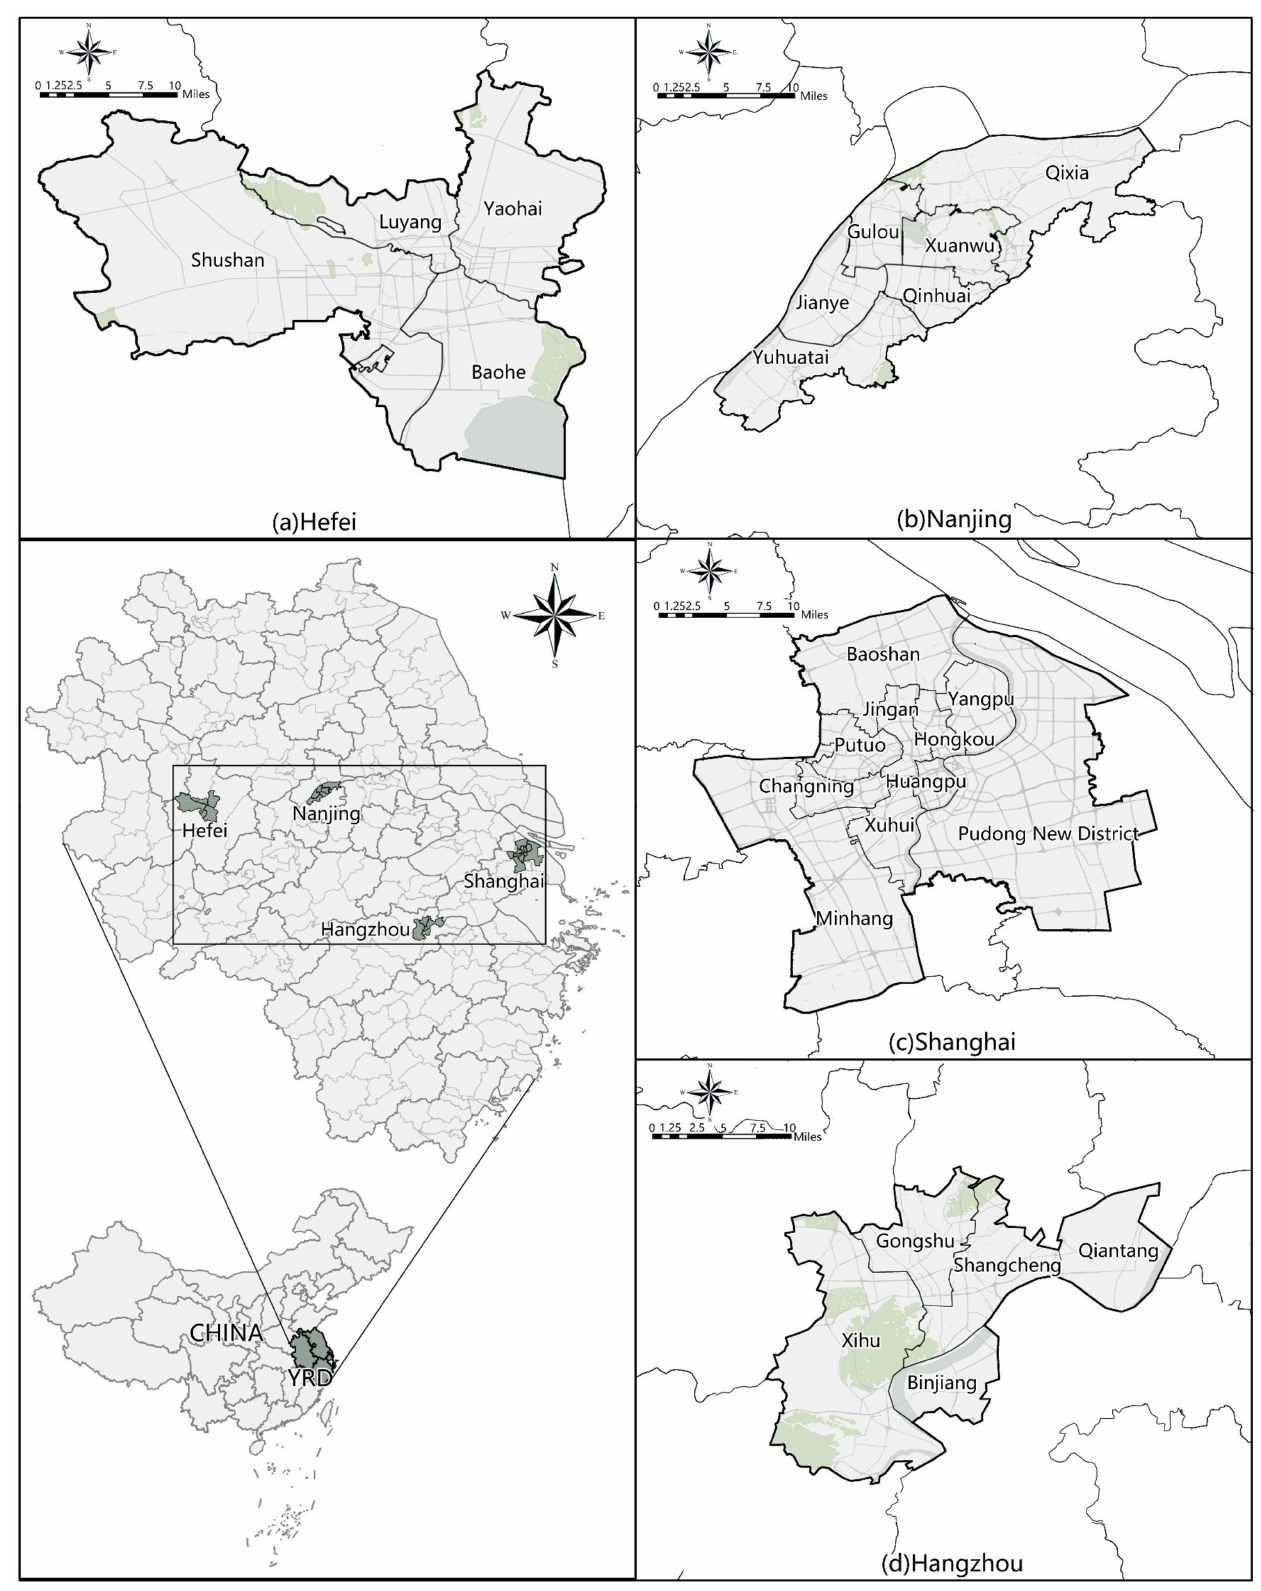
Figure 1. The main urban areas and administrative districts of the four central cities in the